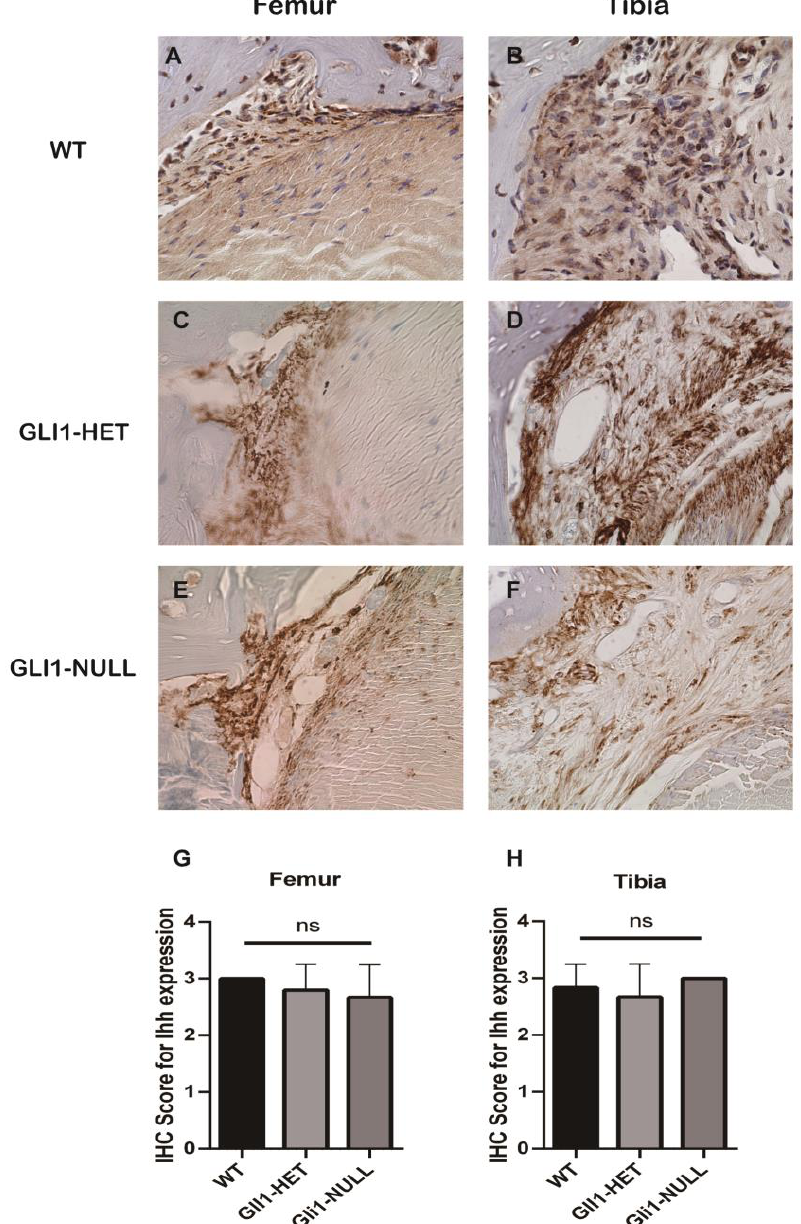
Figure 7. Representative images of IHH immunohistological staining of the tendon–bone interface of wild-type ( A , B ), GLI1-HET ( C , D ) and GLI1-NULL ( E , F ) mice at 4 weeks after ACLR (40×). All three groups had positive IHH expression, with no significant difference among groups ( G , H ). Values are presented as mean ± SD.